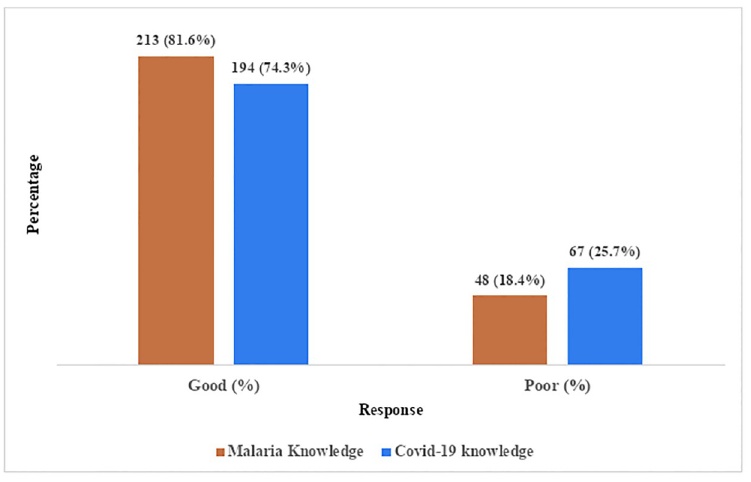
Fig 1. Overall knowledge score of primary healthcare workers on malaria and COVID-19.